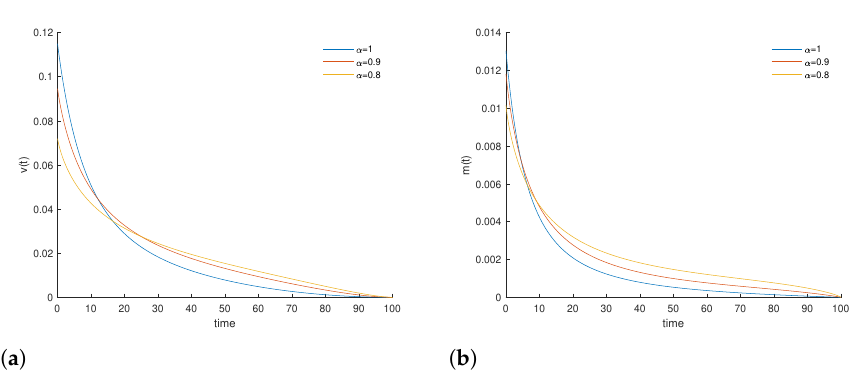
Figure 7. Control variables v and m of the FOCP (8)–(13) with values from Table 1 and fractional order derivatives α = 1.0, 0.9 and 0.8. ( a ) Contour of vaccination, v ; ( b ) Evolution of control of hygiene, m .